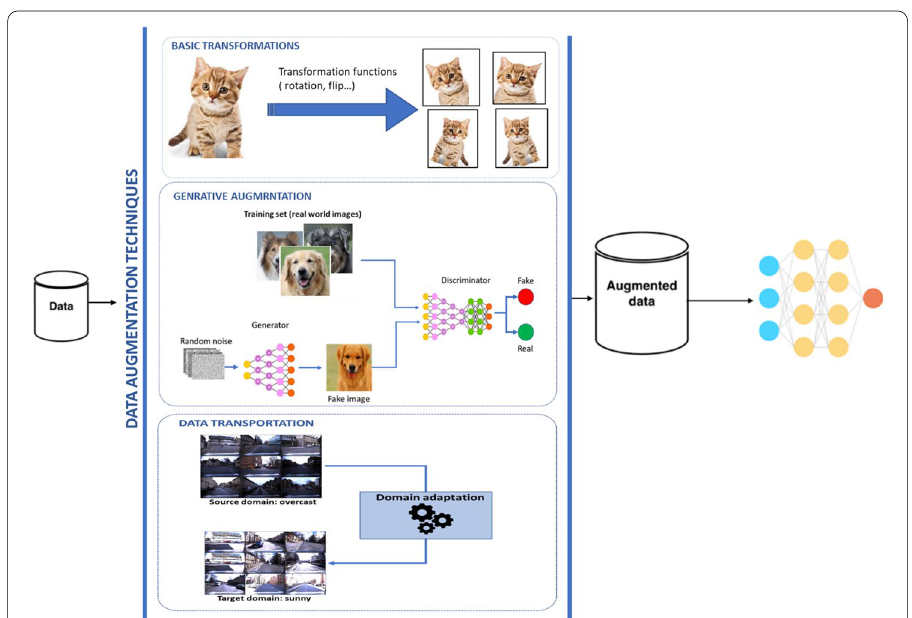
Fig. 7 Main augmentation techniques (images for domain adaptation are from